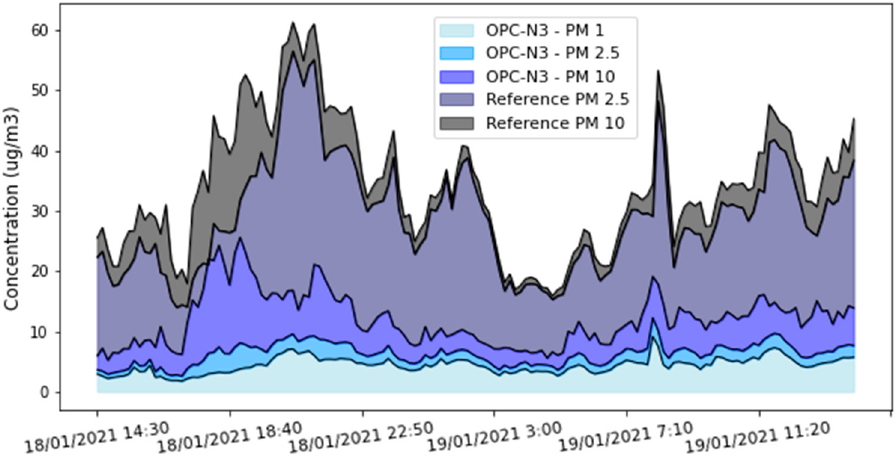
Figure 6. Time series of PM measured by reference and OPC-N3.